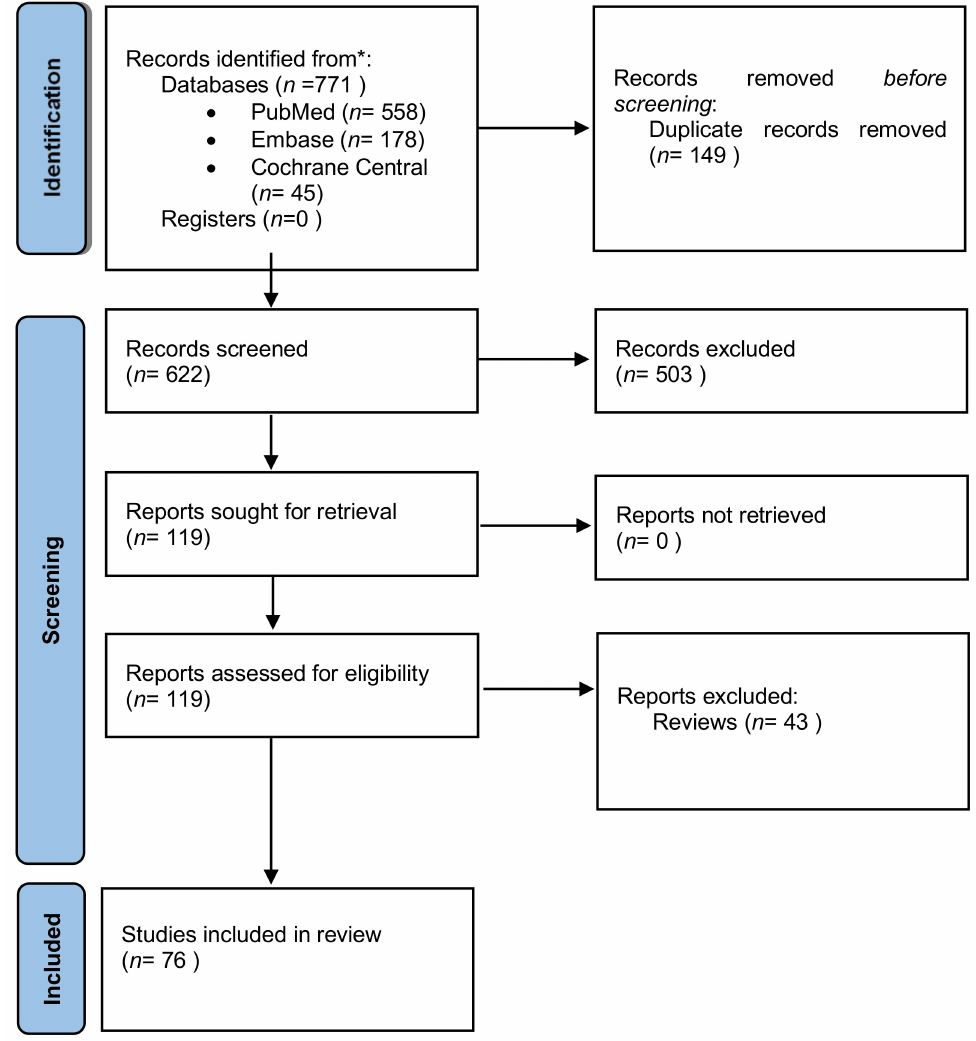
Figure 1. PRISMA flowchart regarding study